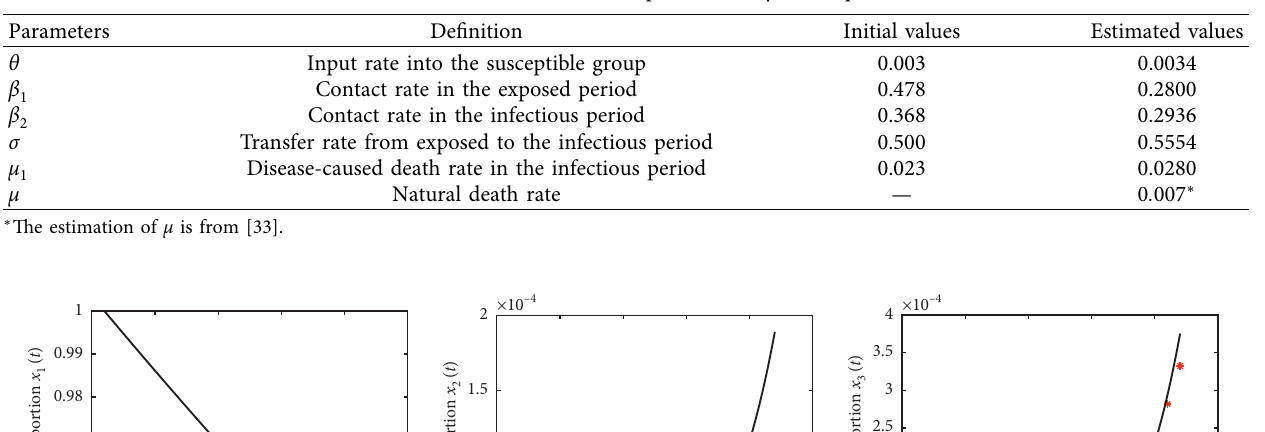
( t ) , and (c) true and fitted curves of x 2